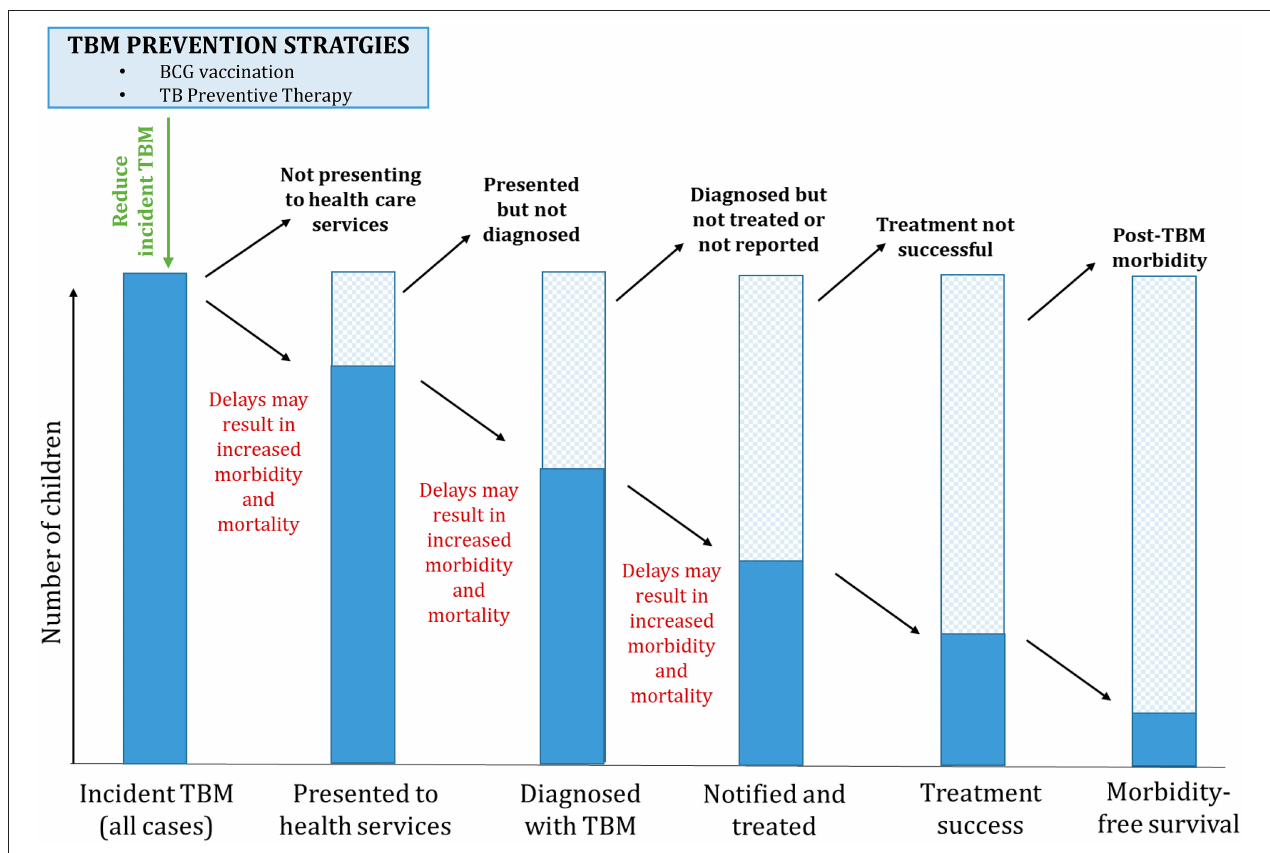
FIGURE 2 | A care cascade for pediatric TBM. TBM, tuberculous meningitis; TPT, TB preventive therapy; BCG, Bacille